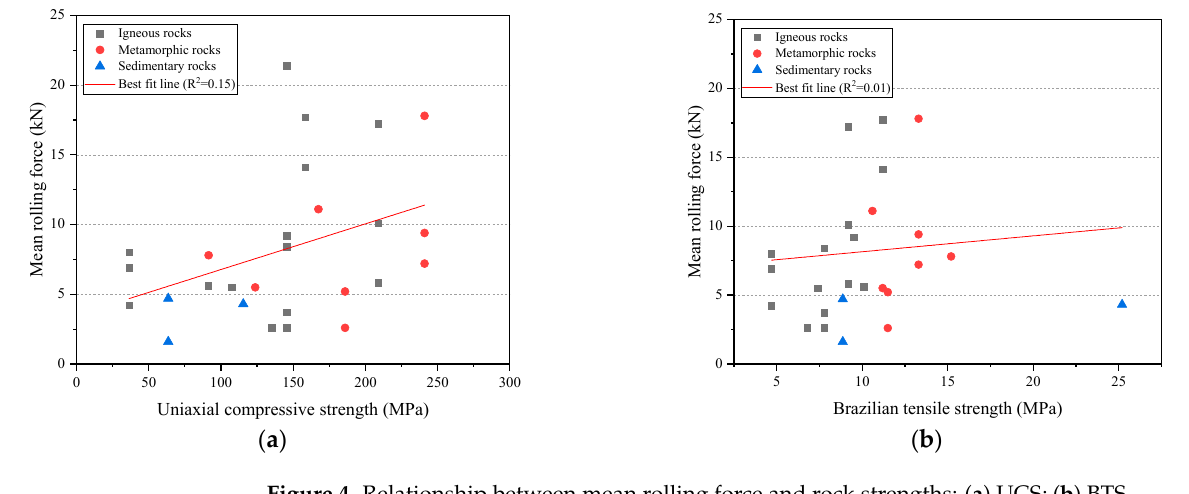
Figure 4. Relationship between mean rolling force and rock strengths: ( a ) UCS; ( b ) BTS. To diminish the effect of the penetration depth, the boreability index (BI) can be used for the quantitative analysis of the relationship between rock strengths and cutter forces. The BI is usually called the field penetration index (FPI). The BI is calculated as the ratio of the normal force to the penetration depth, while the FPI is calculated as the ratio of the thrust per each cutter to the penetration depth per revolution [37,39]. Figure 5 shows the relationship between the BI and cutter forces. The results show that significant linear relationships were found in the case of the normal force, as shown in Figure 5a. However, the rolling force had a poor correlation with the BI, as shown in Figure 5b. The rolling force is usually estimated based on the empirical relationship between the normal force and the rolling force. This relationship can be expressed as the concept of the cutting coefficient (CC), which is defined by the ratio of the rolling force to the nor- this study was 8% on average, and the CC range was consistent with the findings of pre- vious studies [30,37]. However, as shown Figure 6b, there are no significant relationships between CC and rock strengths in the database. The result is not consistent with the find- ing from the previous study [37].